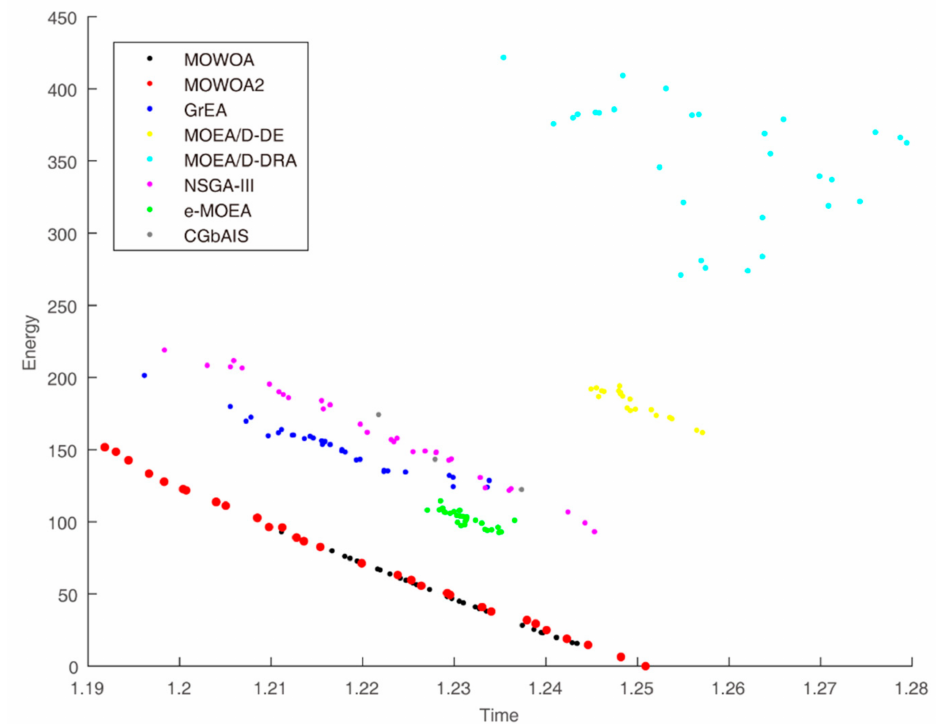
Figure 3. Time and energy consumption of the different algorithms when the user number is